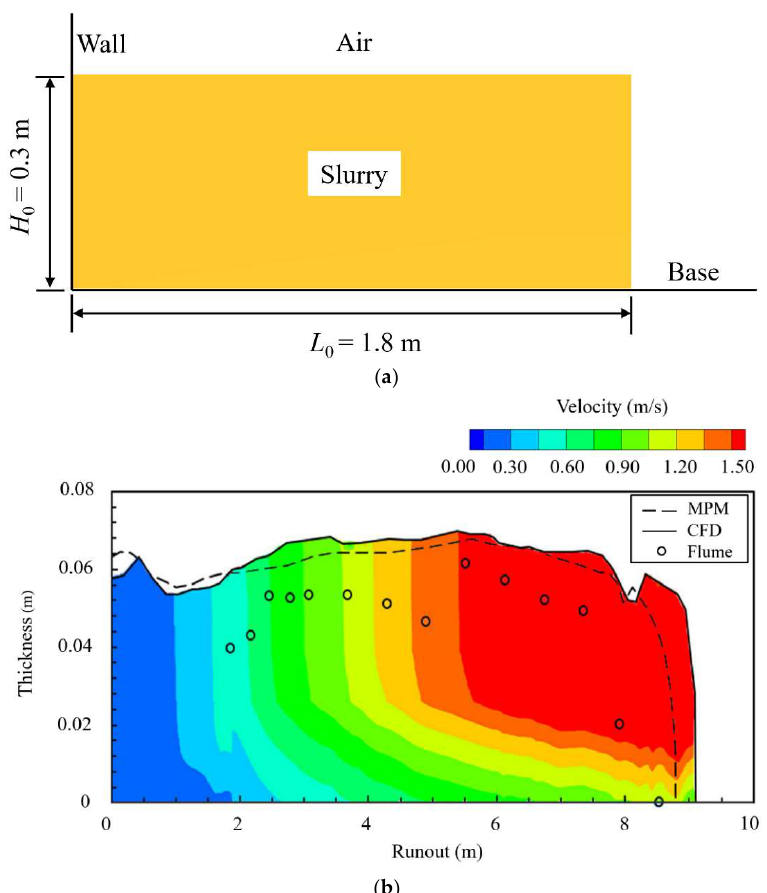
Figure 3. Simulation of the dam break case with the multi-phase framework. ( a ) Initial geometry of the dam break case (not to scale); ( b ) Runout profile at 4.1 s.